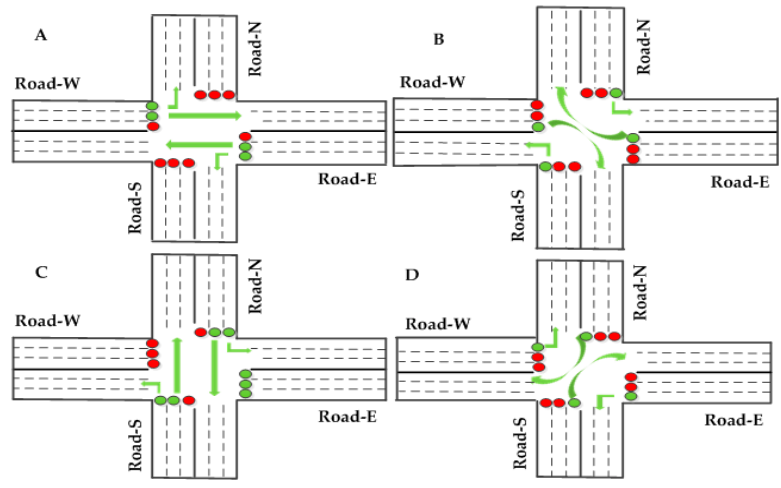
Figure 8. Maximum intersection utilization configuration [50].